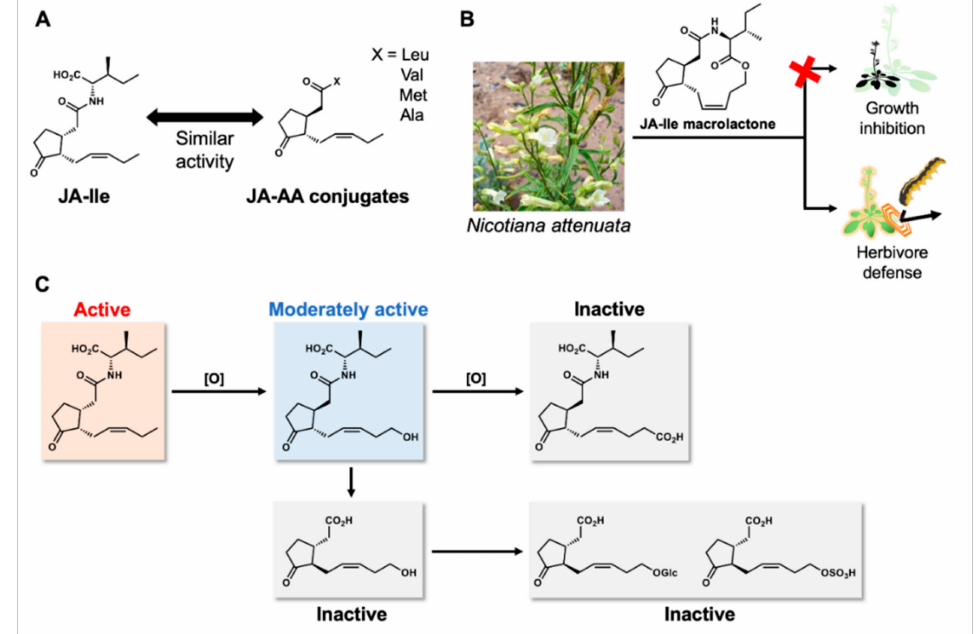
Figure 5. Other chemicals involved in the tuned regulation of jasmonate signaling. ( A ) JA amino acid conjugates with JA-Ile like activity; ( B ) JA-Ile macrolactone uncouples growth-defense trade-o ff ; and ( C ) known metabolites of JA-Ile and their JA-Ile like activity, red “ × ” means ‘without causing growth